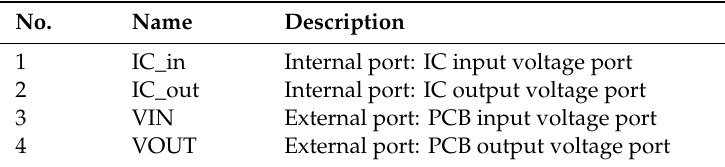
Figure 13. Y parameter simulation results. Theoretically, the output interference signals